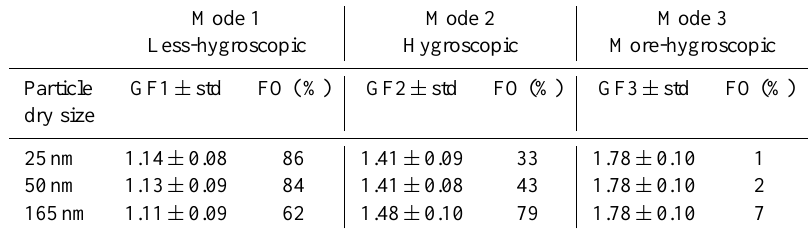
Table 3. Summary of HTDMA observations at the Puy de Dôme for measurement years 2011–2012. Growth factor (GF) average and frequency of occurrence (FO) for each hygroscopic mode (less-hygroscopic, hygroscopic and more-hygroscopic) and particle dry size at RH90.